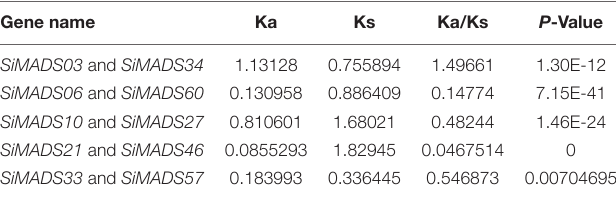
TABLE 2 | The Ka, Ks, and Ka/Ks values of the duplicated SiMADS-box